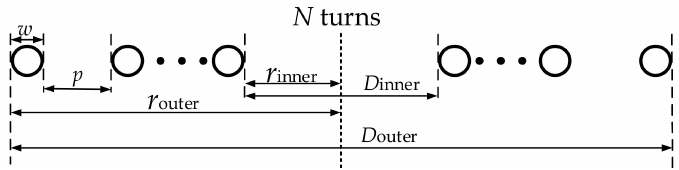
Figure 3. Section view of a circular flat spiral